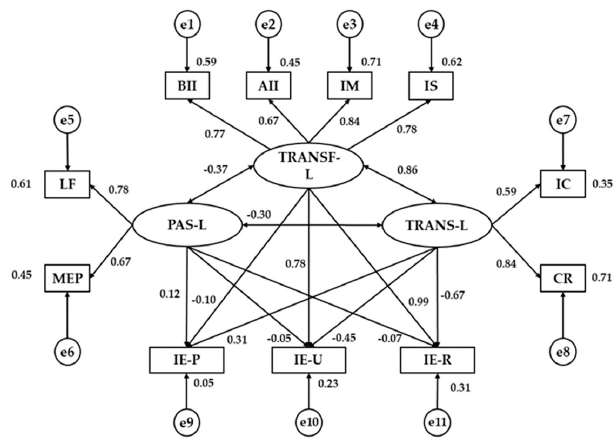
Figure 2. Structural equation model for inferior teachings. Note1: TRANF-L, Transformational